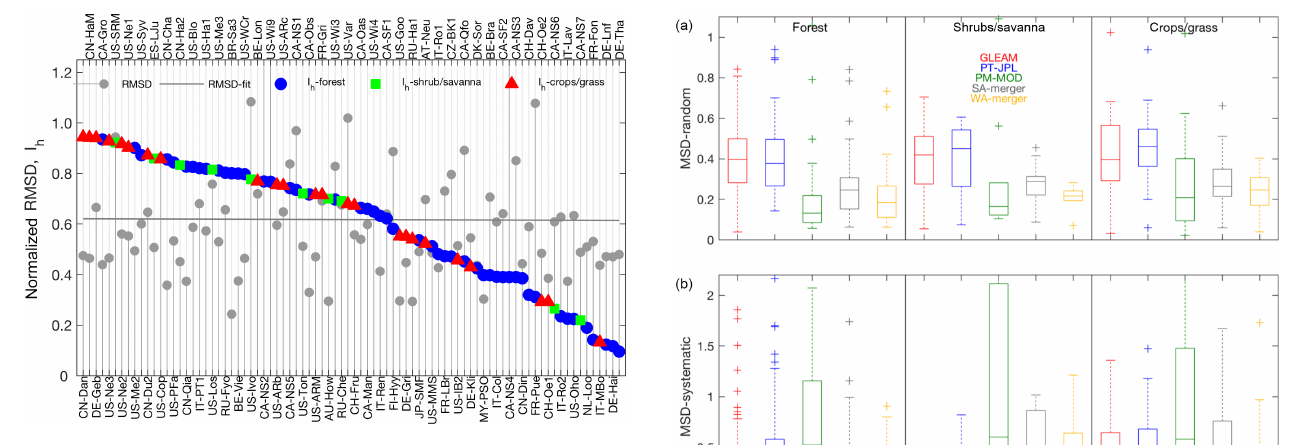
Figure 10. Homogeneity index ( I h ) and RMSD of SA-merger and the towers’ ET. The I h is plotted as closed circles in blue for forest stations, green for shrubs/savanna, and red for crops/grass, while the RMSD, normalized by the mean annual tower ET, is plotted in grey. A linear fit to the normalized RMSD is given by the grey line. The towers are sorted from maximum to minimum I h , with the tower names given at the bottom and top of the figure.